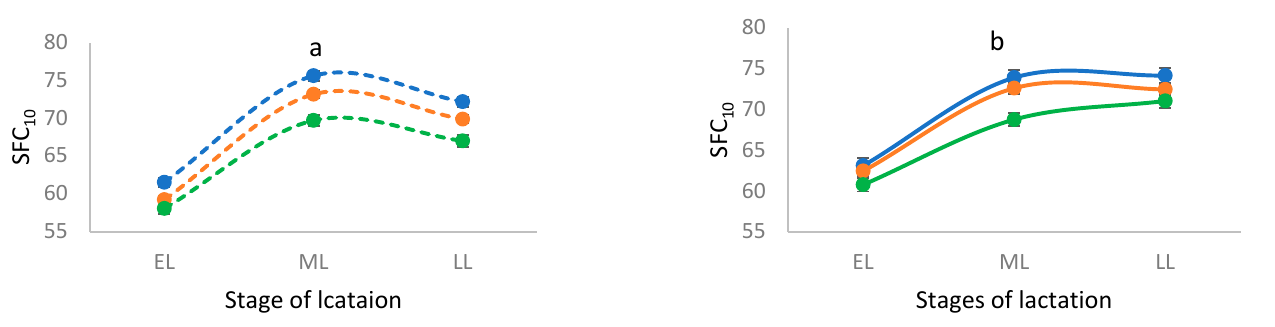
Figure 2. Proportions of ( a ) C4:0, ( b ) C16:0, and ( c ) C18:1 cis -9 for genotypes CC (….), CT ( …. ), and TT ( …. ) in cows milked once a day, and proportions of ( d ) C4:0, ( e ) C16:0, and ( f ) C18:1 cis -9 for genotypes CC ( — ), CT ( — ) and TT ( — ) in cows milked twice a day during the production season 2020–2021. EL = early lactation (<90 days); ML = mid lactation (90–180 days); LL = late lactation (>180 days). The vertical bars show standard errors.